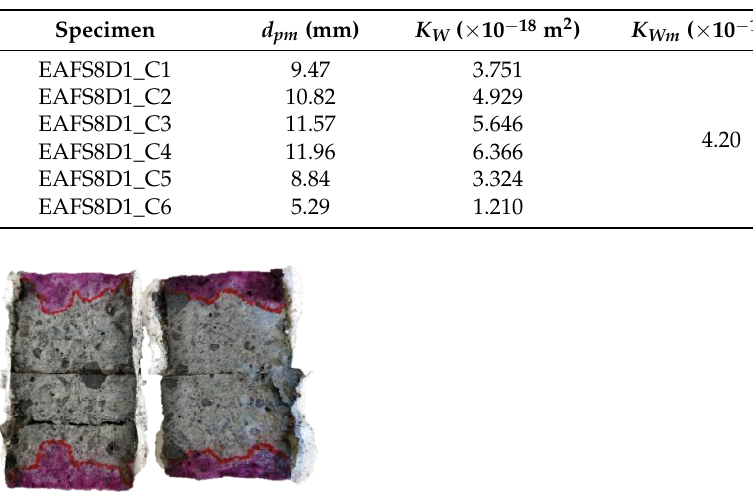
Figure 8. Representative EAFS8D1 specimens after water permeability test. Table 16. Results of air permeability obtained for EAFS8D1 mixture.